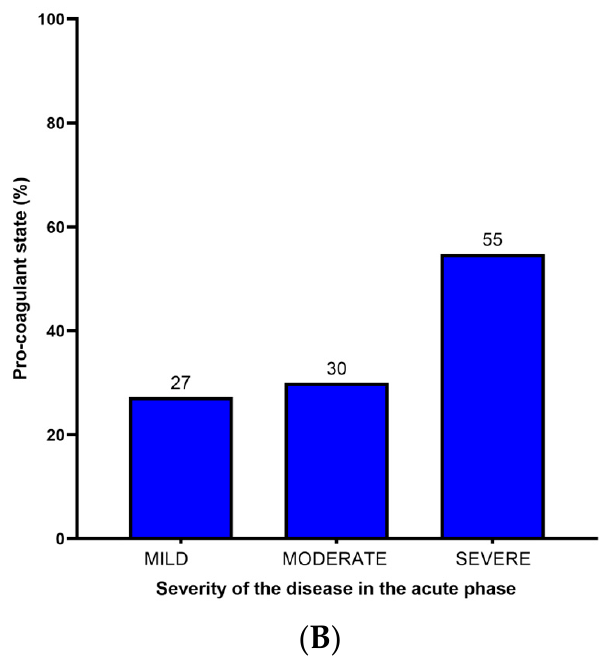
Figure 2. Rate of procoagulant state persistence based on the age at acute phase stage (Panel ( A )) and severity of the acute phase disease (Panel ( B )).